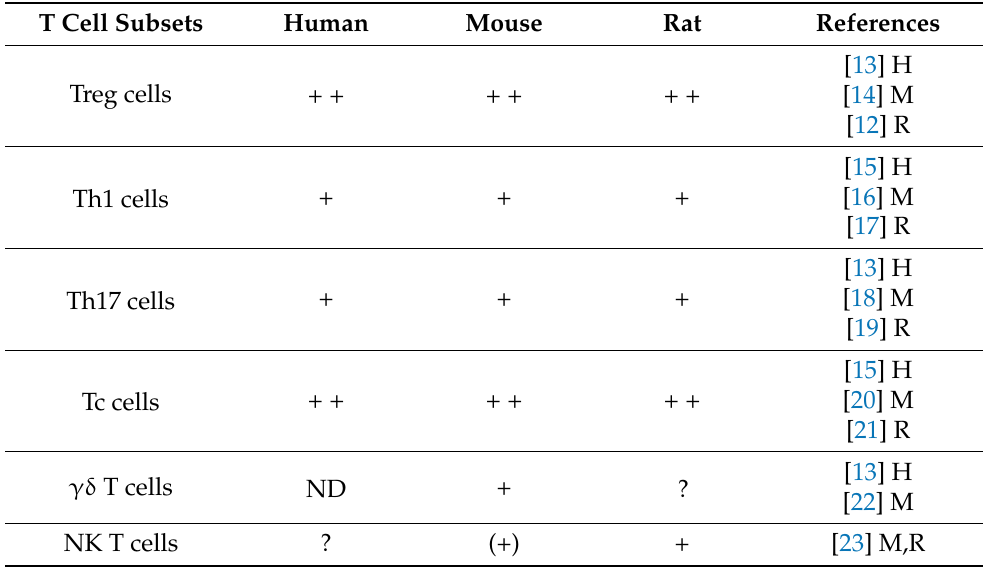
Table 1. T lymphocytes in normal human, mouse, and rat